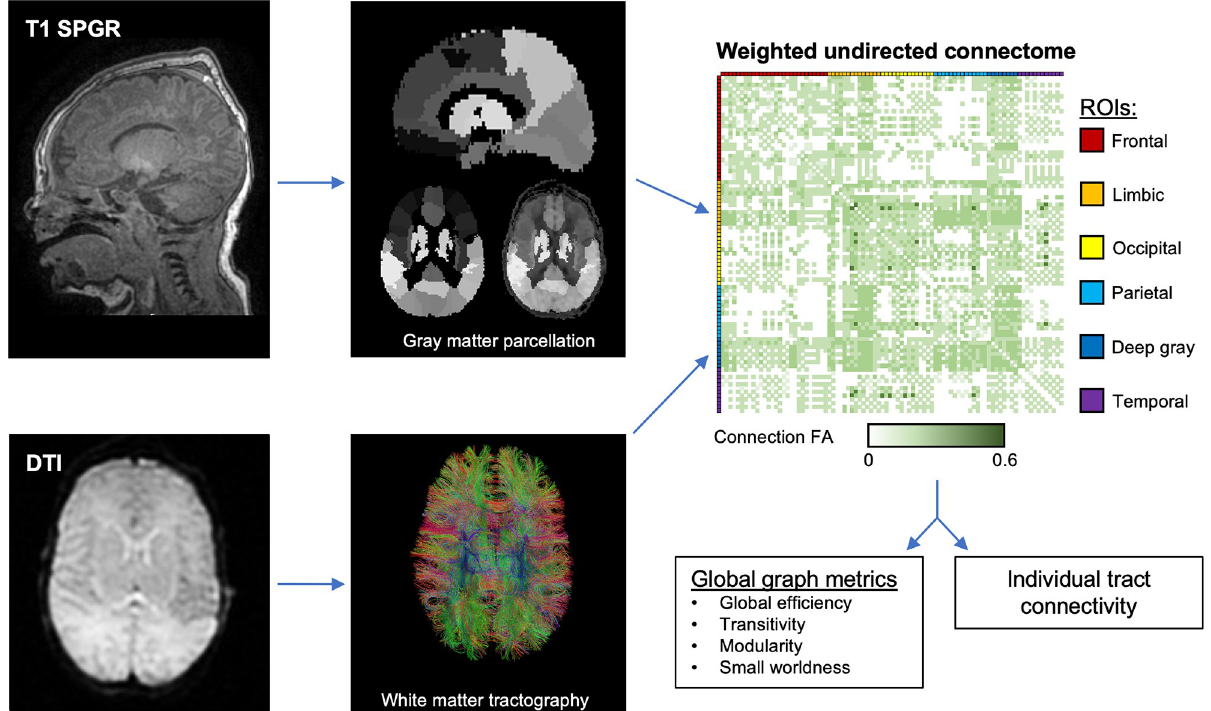
Fig 2. MRI processing. T1 images are registered to the neonatal UNC Infant 012 Atlas and visually inspected for motion degradation. An automated rejection algorithm inspects and eliminates corrupted directions of DTI imaging, and deterministic tractography is performed to create white matter tracts. The connectome, a weighted undirected adjacency matrix between each of the 90 cerebral regions of interests (ROIs) is created, with average fractional anisotropy (FA) along the connecting tracts used as weights. Connection patterns are described using global graph theory metrics and individual tract connectivity is